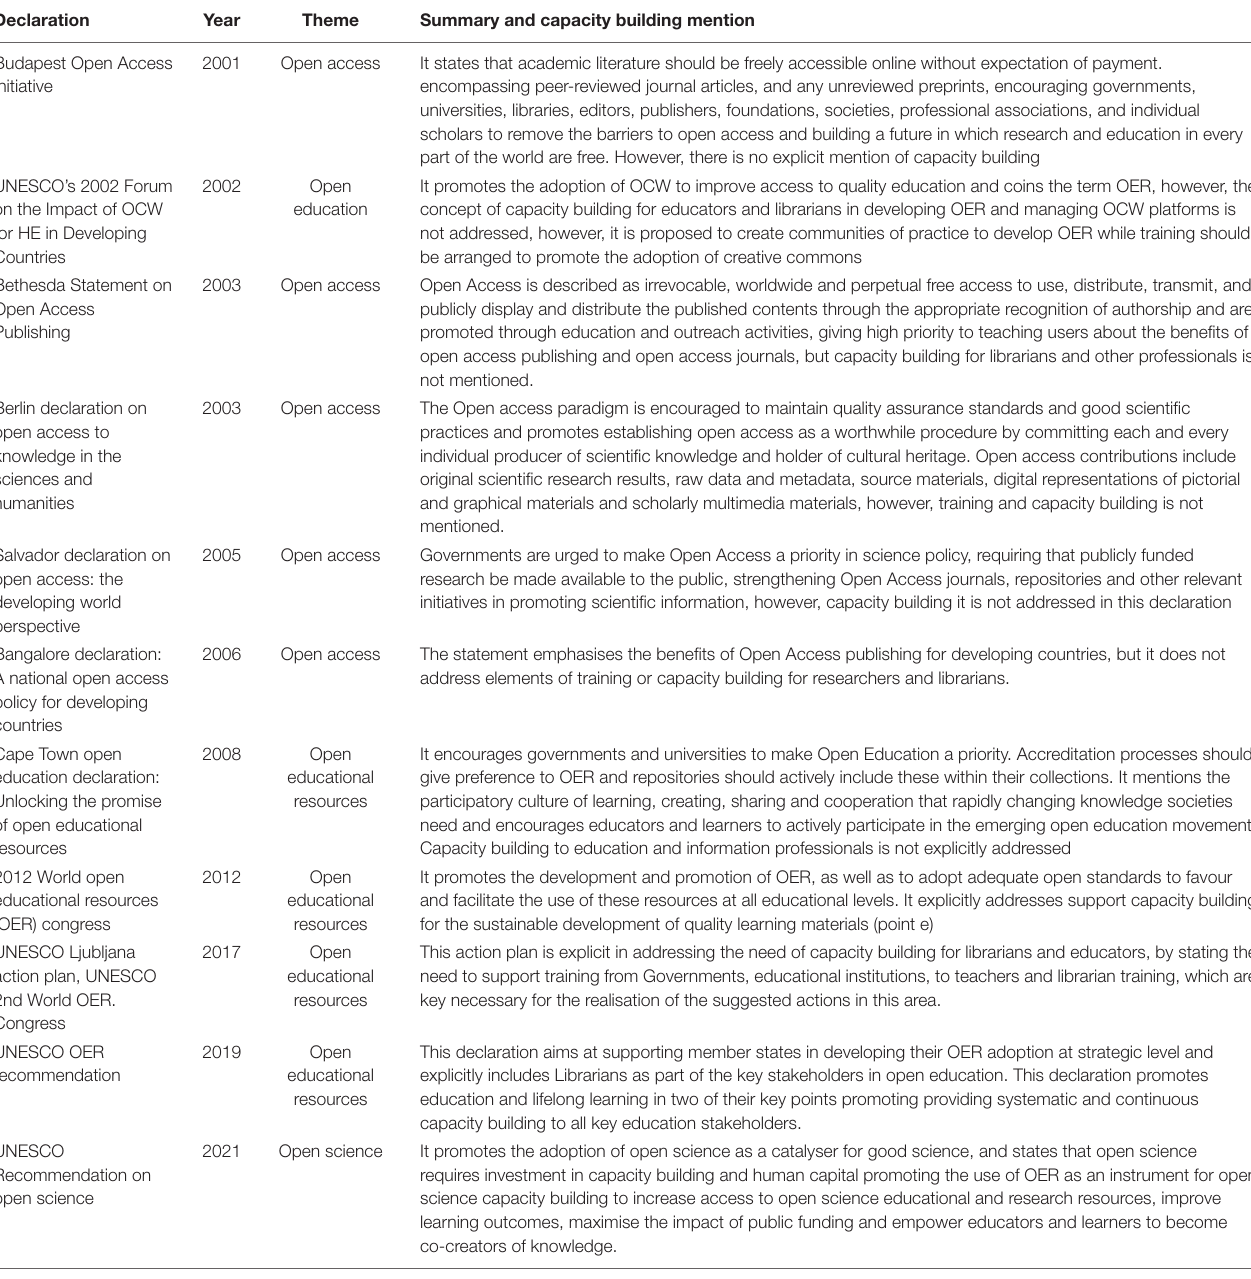
TABLE 1 | Capacity building in OA, OSC, and OE, a review of recommendations and